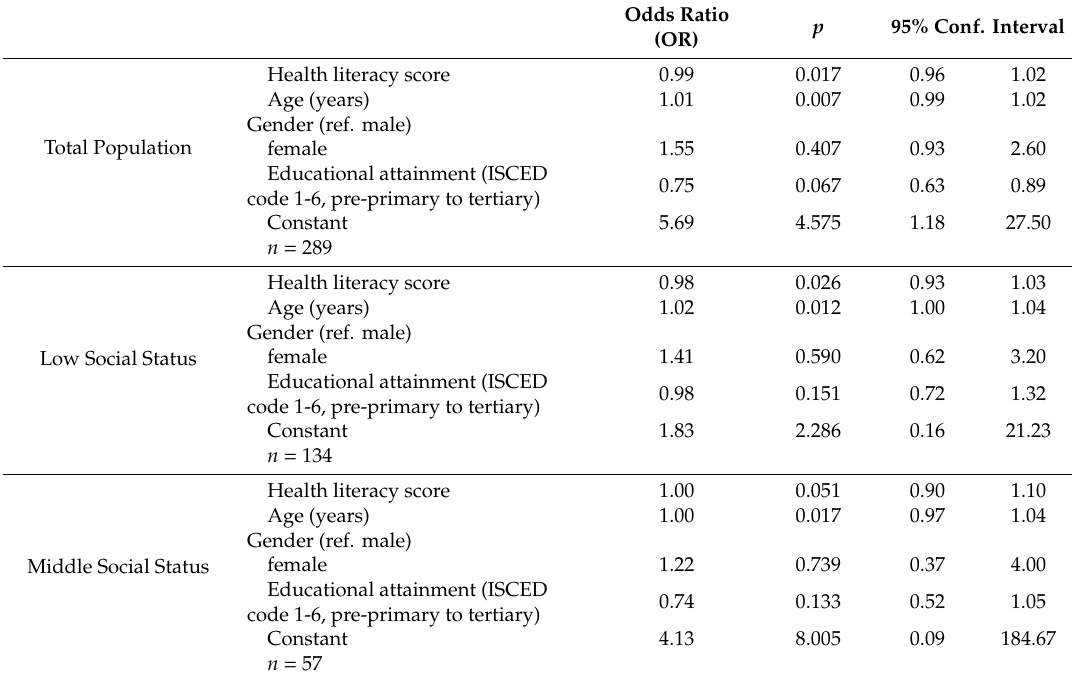
Table A4. Long-standing health condition logistic